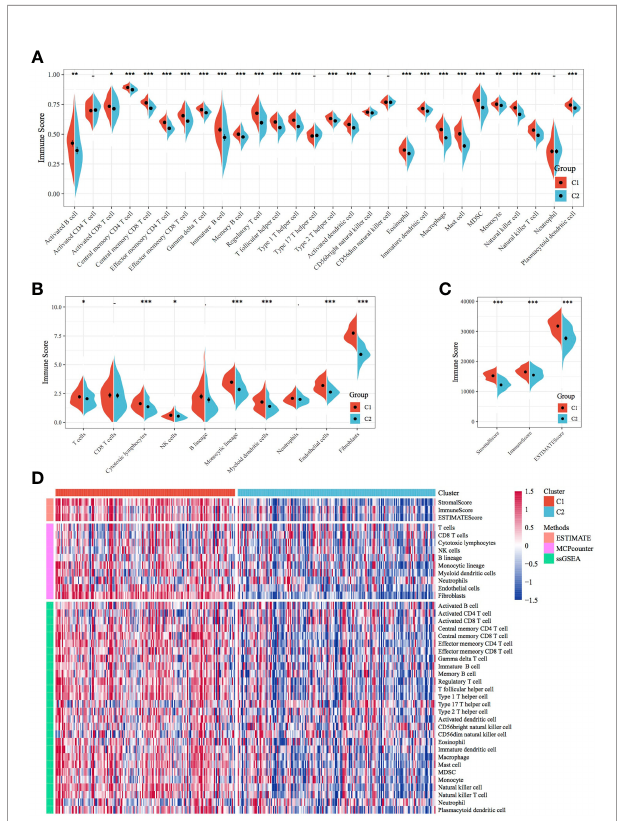
FIGURE 3 | Comparison of immune scores and immune subtypes between molecular subtypes. (A) Comparison of immune scores calculated using ssGSEA between the molecular subtypes of TCGA dataset. (B) Comparison of immune scores calculated using MCPcounter between the molecular subtypes of TCGA dataset. (C) Comparison of immune scores calculated using ESTIMATE between the molecular subtypes of TCGA dataset. (D) Clustering heatmap of molecular subtypes of immune in fi ltration patterns between different algorithms. *p < 0.05, **p < 0.01, ***p <